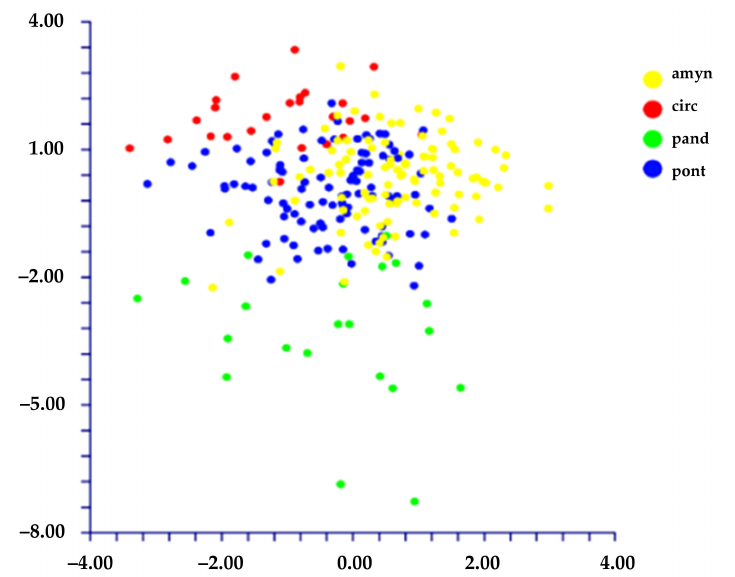
Figure 7. DA (first ( x axis) vs. second ( y axis) components) performed on groups classified using the species names (amyn = L. amynclaeum ; circ = L. circaei ; pand = L. pandatariae ; pont = L. pontium ).